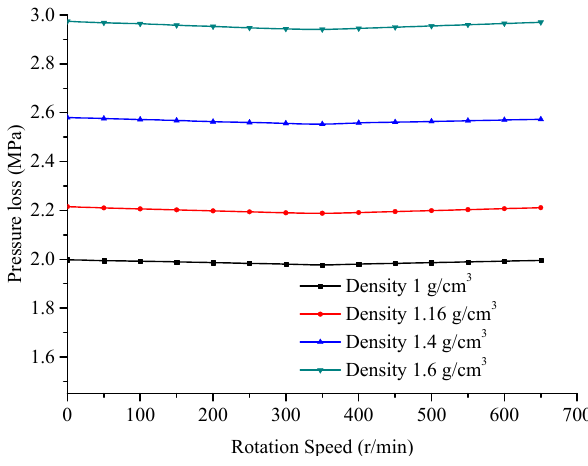
Figure 14. Pressure drop vs. speed curves at different densities.